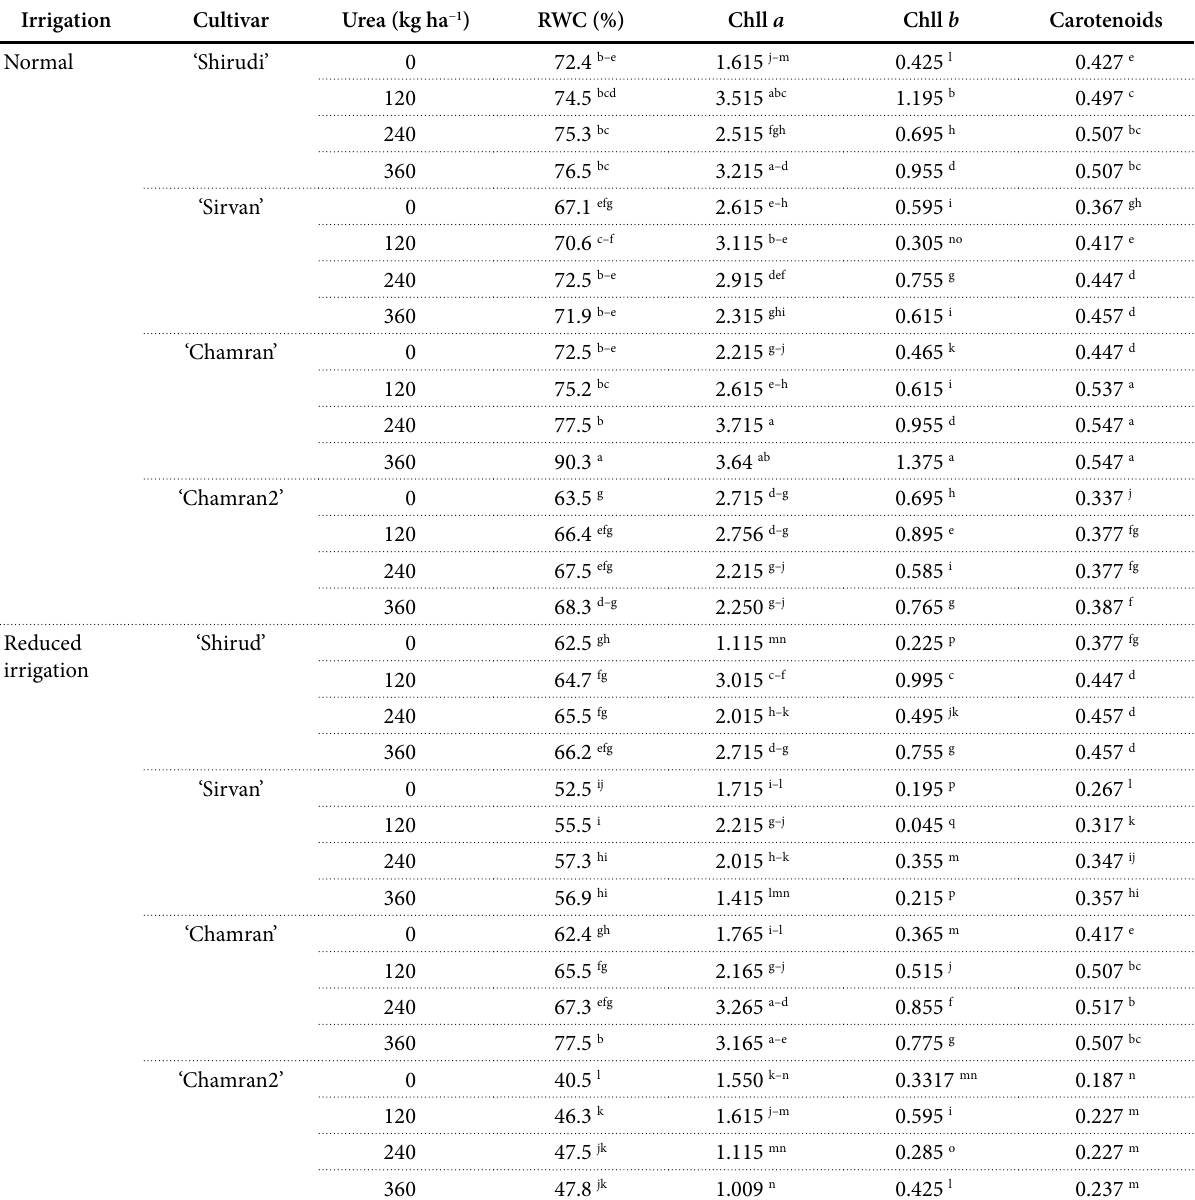
Tab. 4 Mean comparisons for RWC, chlorophyll a , chlorophyll b , and carotenoid concentrations (mg g −1 FW) in response to the experimental